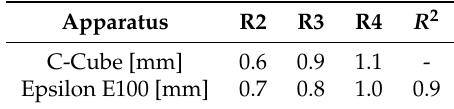
Figure 7. Area of volar forearm captured with C-Cube spectroscope ( left ) and Epsilon E100 capacitive imaging system ( right ). R2-4 the three randomly selected furrows for the comparative experiment. Table 2. Results of comparative study between C-Cube spectroscope and Epsilon E100 to examine accuracy of wrinkle length estimation using GLCM. The length of three wrinkles in the area of volar forearm was compared and the correlation between the two measurement methods is calculated to